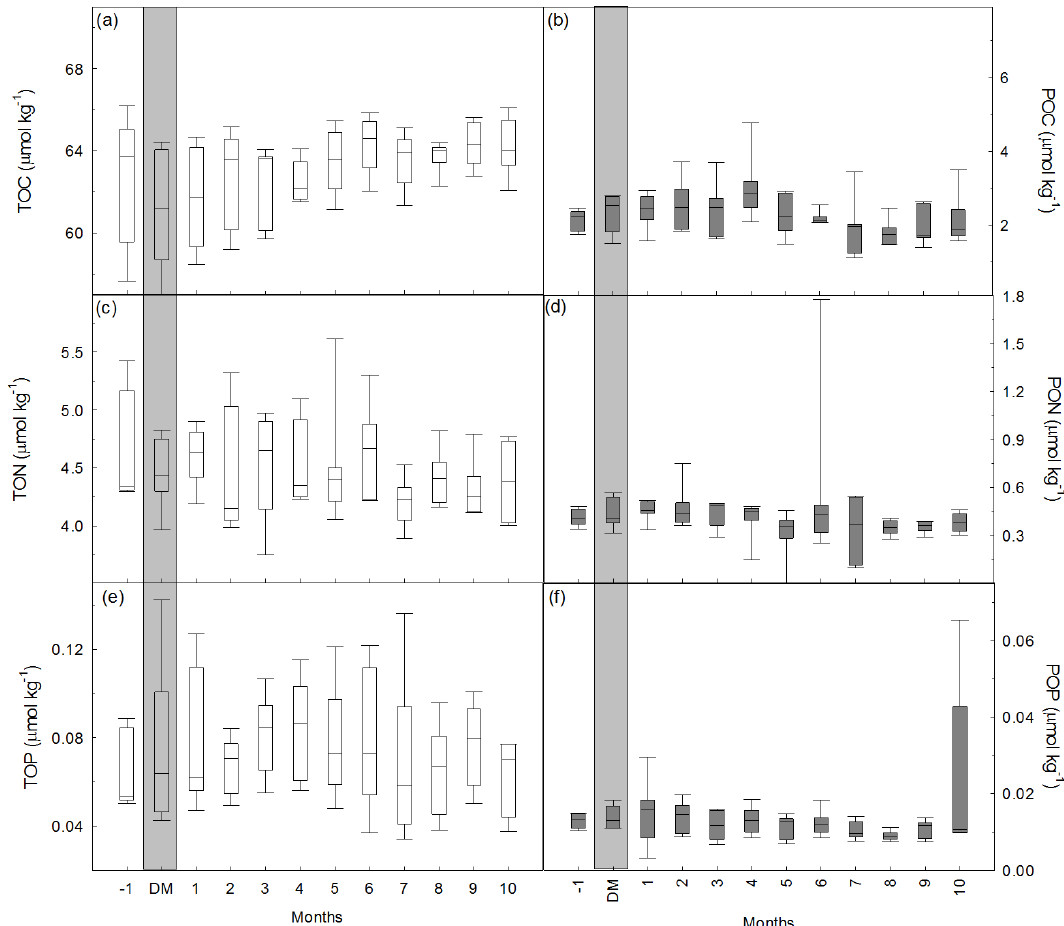
Figure 5. Box–whisker plot comparing the annual concentrations of total (open bars) and particulate (filled bars) matter relative to the deep mixing at a depth of 25–100m (data used are from January 2005 to December 2011). All else as in Fig.